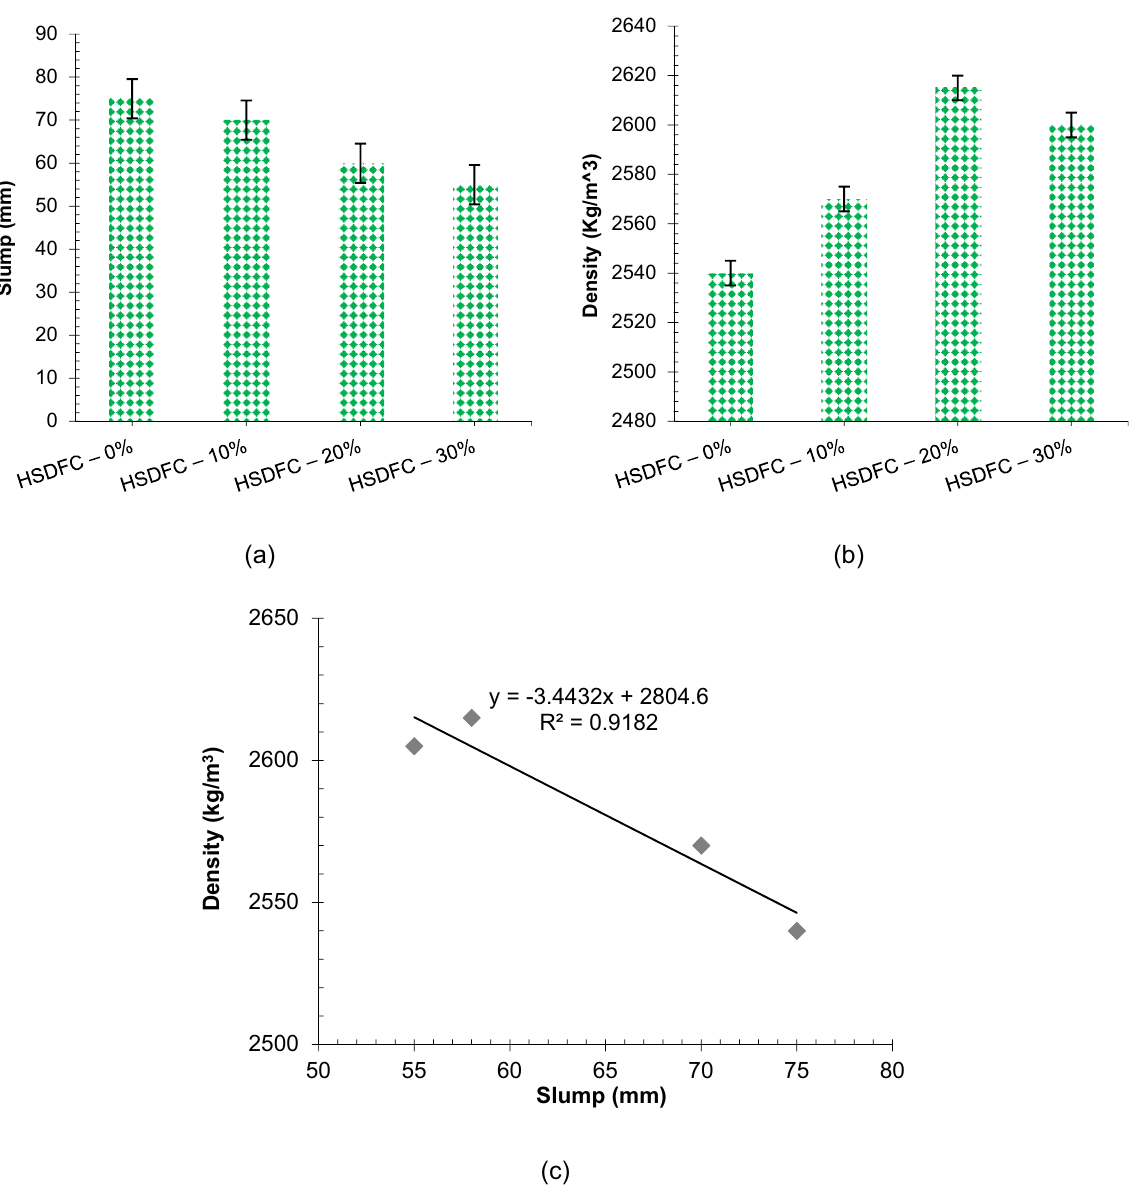
Figure 3. ( a ) Slump, ( b ) Fresh density, and ( c ) Co relation between a slump and fresh